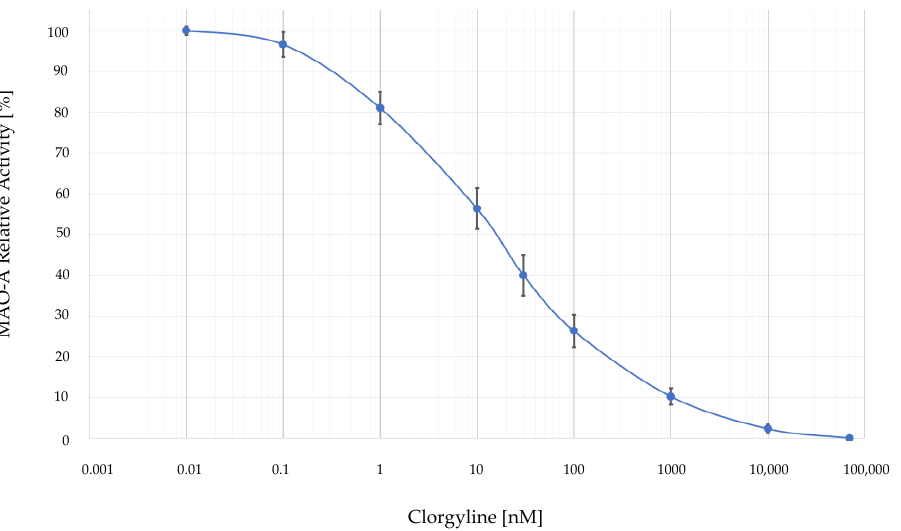
Figure 4. Concentration-response curve of the MAO-A relative enzymatic activity after application of clorgyline at the range of 0.1 and 1000 nM. All points that defined the constructed curve represented MAO-A relative activity in percentages as MEAN ± STDV. The number of the performed experiments was n = 8.